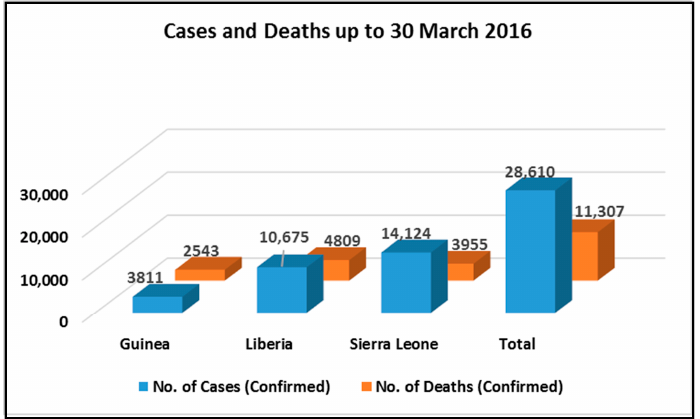
Figure 1. Ebola situation report March 2016. Ebola virus disease cases and deaths. Data are based on official information reported by the Ministry of Health in an Ebola situation report published on 30 March 2016.